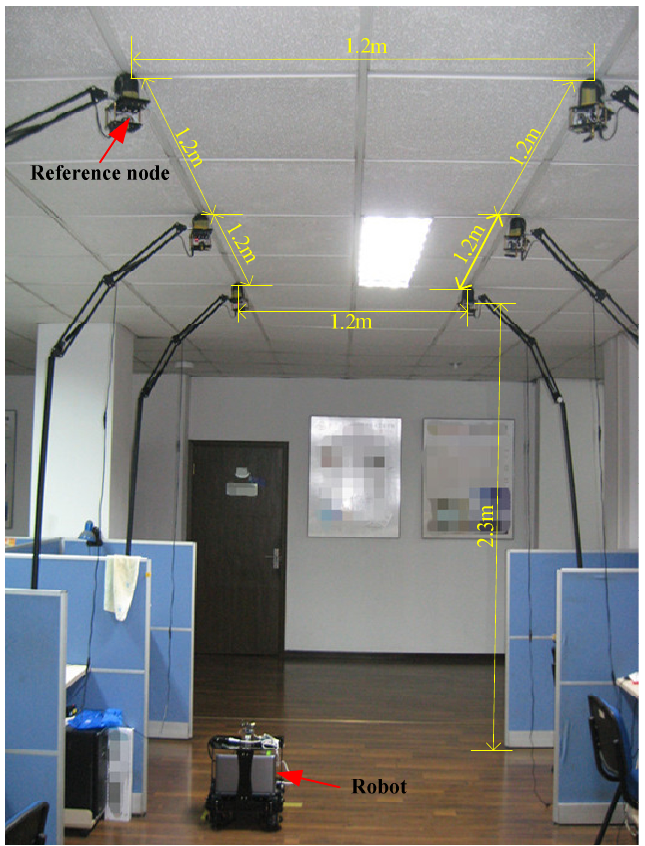
Figure 5. Real indoor test